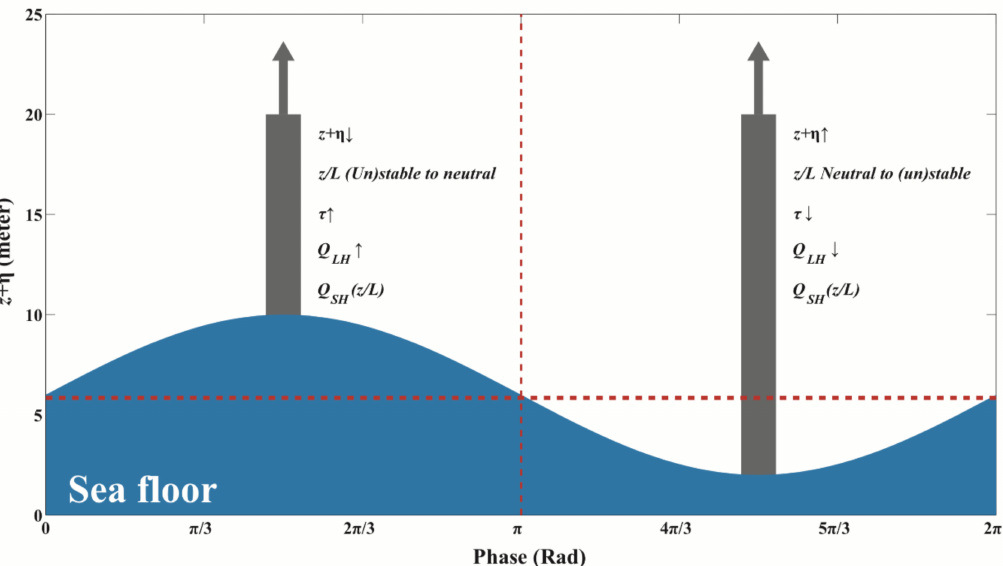
Figure 18. Schematic of the effect of tidal elevations on platform-based air-sea turbulent fluxes. The x-axis represents the tidal phase, while the y-axis represents the SSE. The turbulent fluxes and the boundary condition shifts are marked in the figure. The horizontal red dotted line represents the mean tidal elevations, and the vertical red dotted line represents the dividing line between SSE rising and